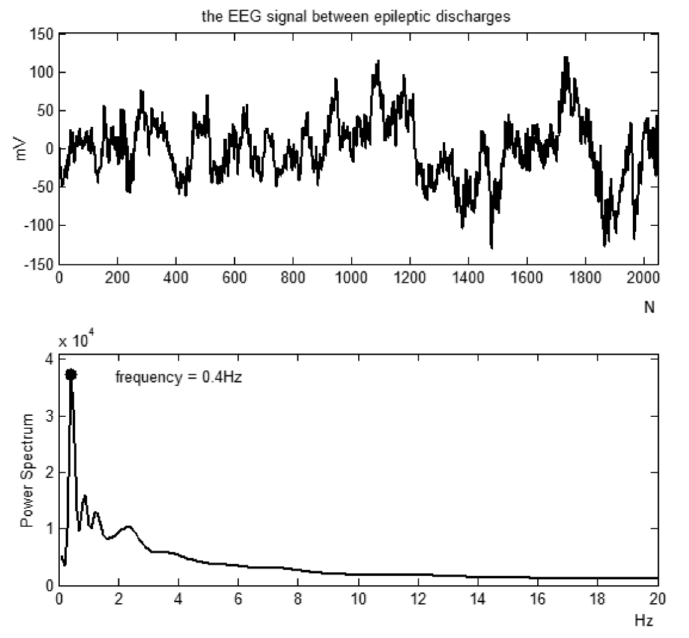
Figure 3. The EEG signal and power spectrum using wavelet transform. Black dot – dominant frequency, the frequency at which most signal energy is transmitted